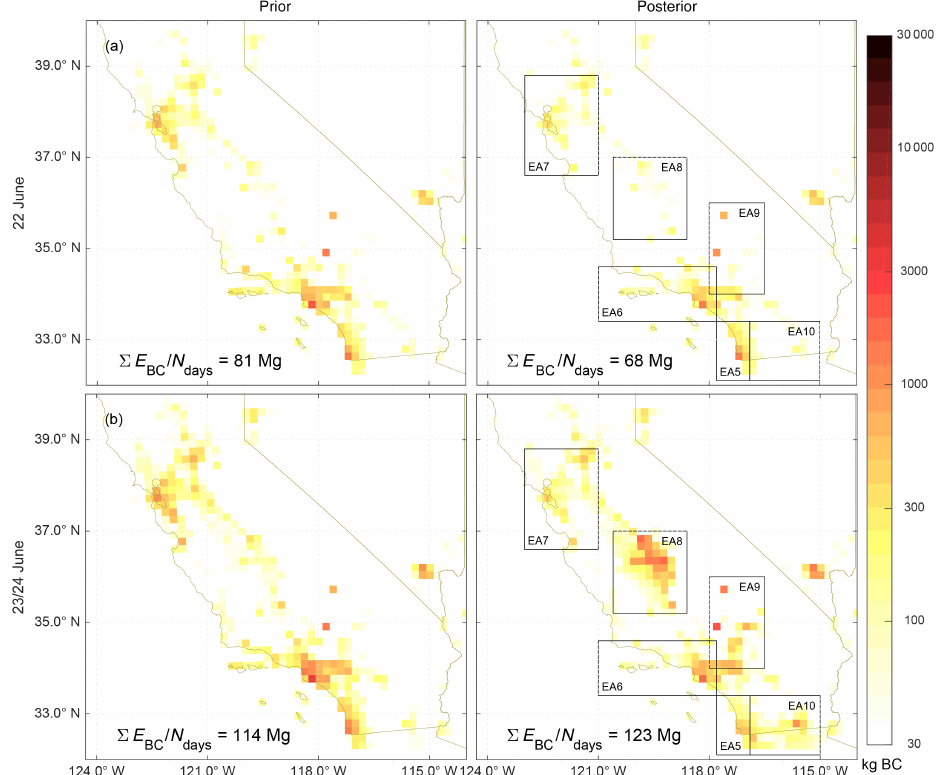
Figure 10. Prior and posterior grid-scale anthropogenic emissions of BC per 24h for FINN_STD on 22 June, 00:00–23:00Z (top row) and 23 June, 00:00Z to 24 June, 23:00Z. EA5–10 are outlined with black boxes.